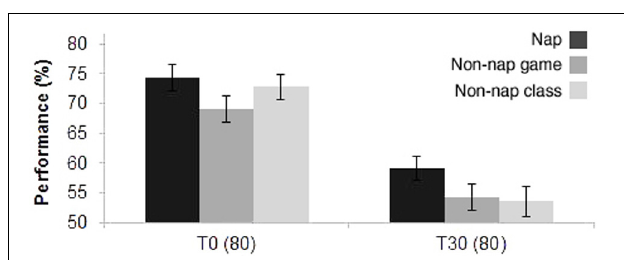
FIGURE 4 | Experiment II—Test performance immediately after the lecture (T0), and 30 days later (T30). Nap ( N = 23), non-nap groups for game class ( N = 30), and non-nap groups for regular class ( N = 27).